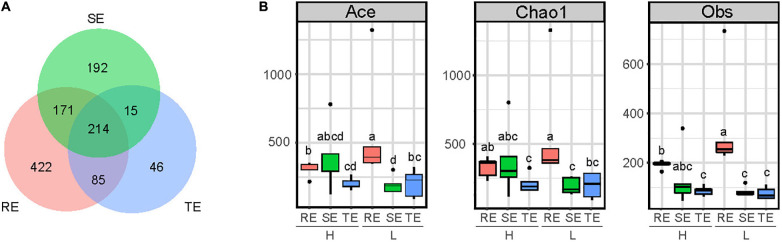
α-diversity of SE, TE, and RE. (A) Number of shared OTUs of RE, SE, and TE. (B) Ace, Chao1, and Obs indexes in RE, SE, and TE with high (H) and low (L) PCS severity. Different letters indicate significant differences at the 5% level (P < 0.05).